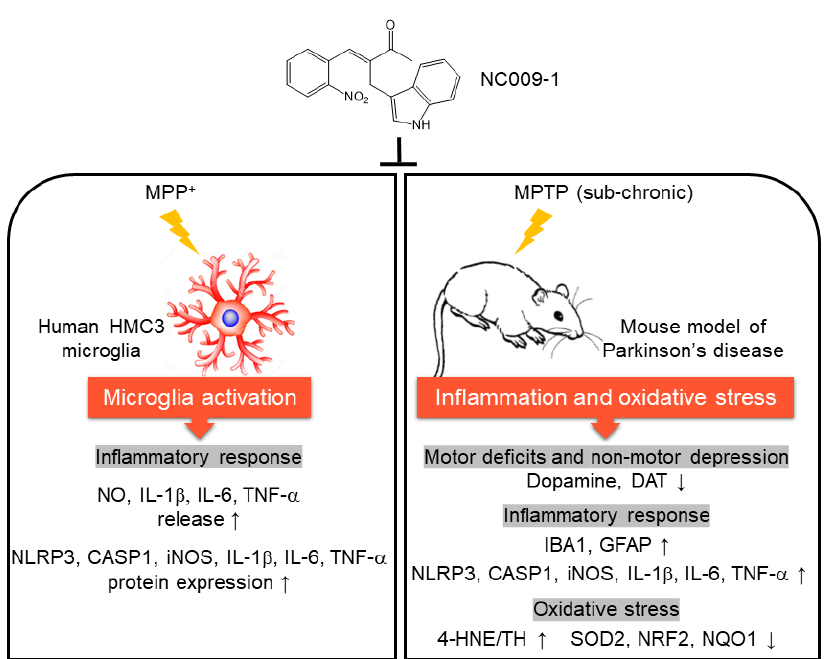
Figure 6. Graphical summary.